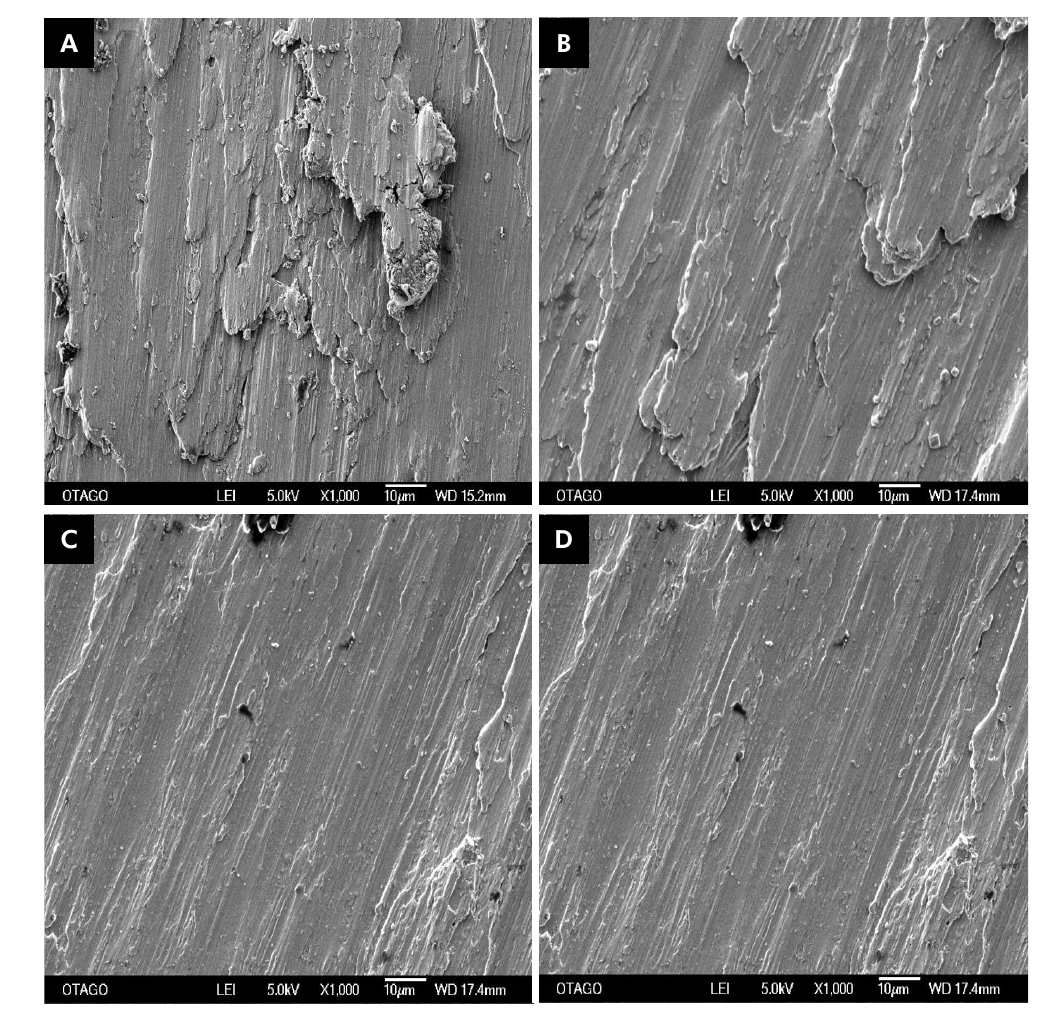
Figure 4. Machined disk surfaces following the corresponding steps of instrumentation (x1000 magnification) a) Step 1 of TPP b) Step 2 of TPP c) Step 3 of TPP d) Step 4 of